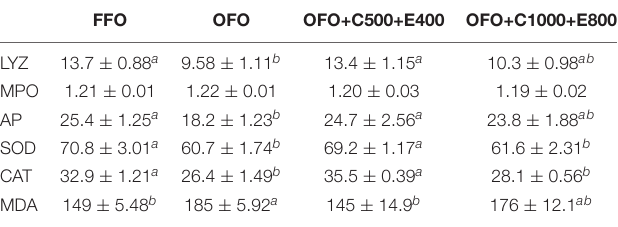
TABLE 6 | Serum innate immunity and antioxidant parameters of rainbow trout fed the experimental diets for 10 weeks.